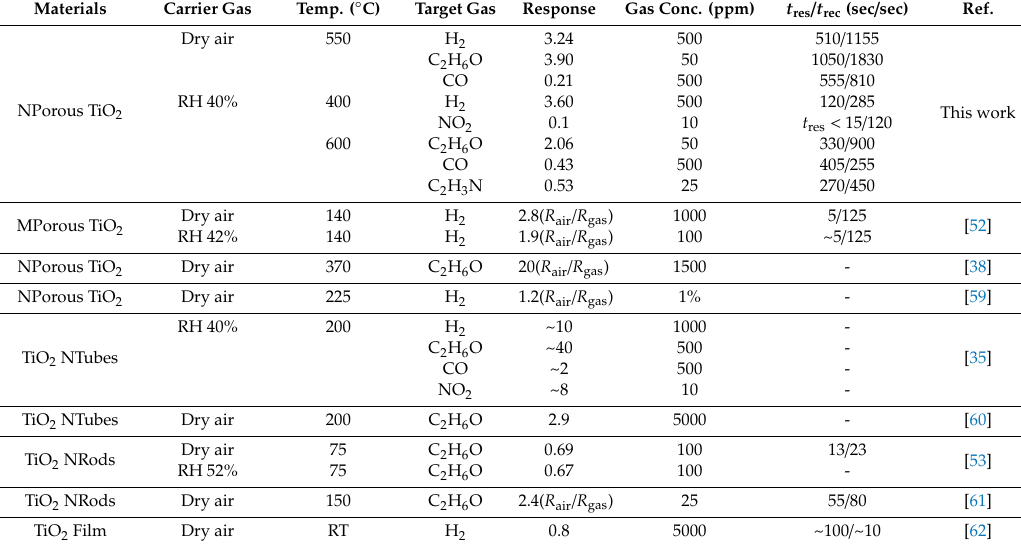
Table 2. Sensing performances of previously reported bare-TiO 2 nanostructure-based gas sensors in comparison with the present